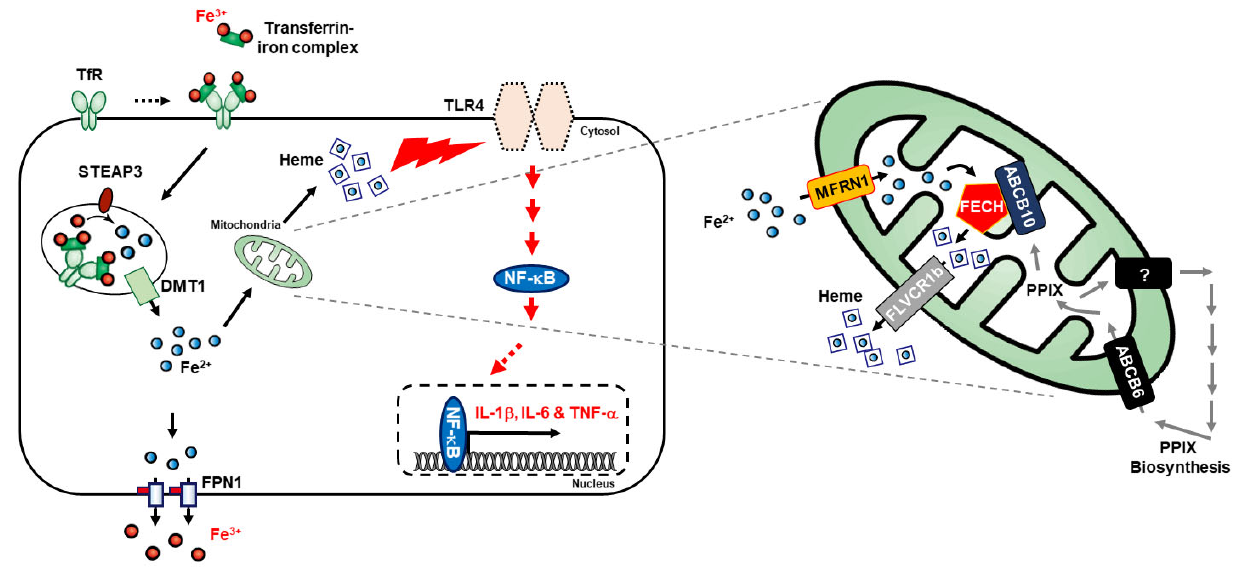
Figure 5. Molecular regulatory mechanism of iron metabolism and heme biosynthesis in inflammatory responses by regulating the TLR4/NF ‐κ B pathway, and thereby mediating pro ‐ inflammatory cytokines, IL ‐ 6, IL ‐ 1 β , and TNF ‐α .